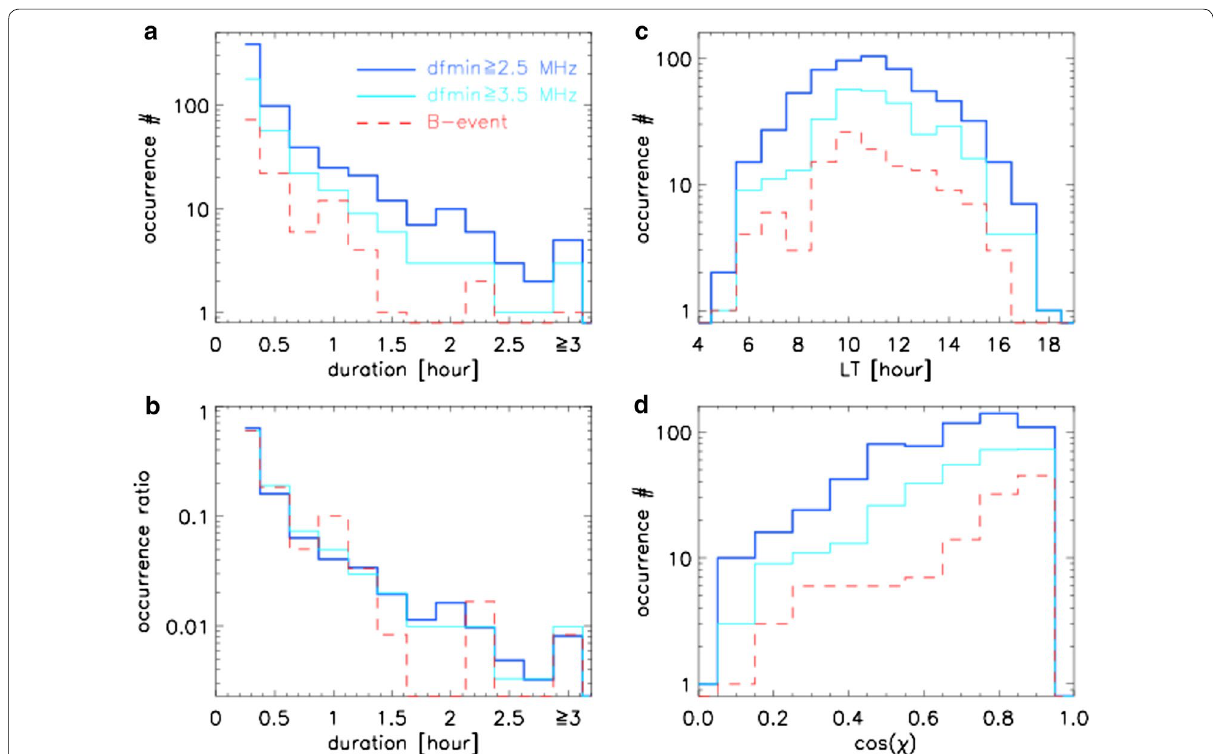
Fig. 4 Histograms of a SWF event number and b occurrence ratio as a function of SWF event duration, and histograms of SWF event number as a function of c LT ( UT 9 h) and d solar zenith angle for SWF events with the criteria of d f min = + lines), and blackout (red dashed